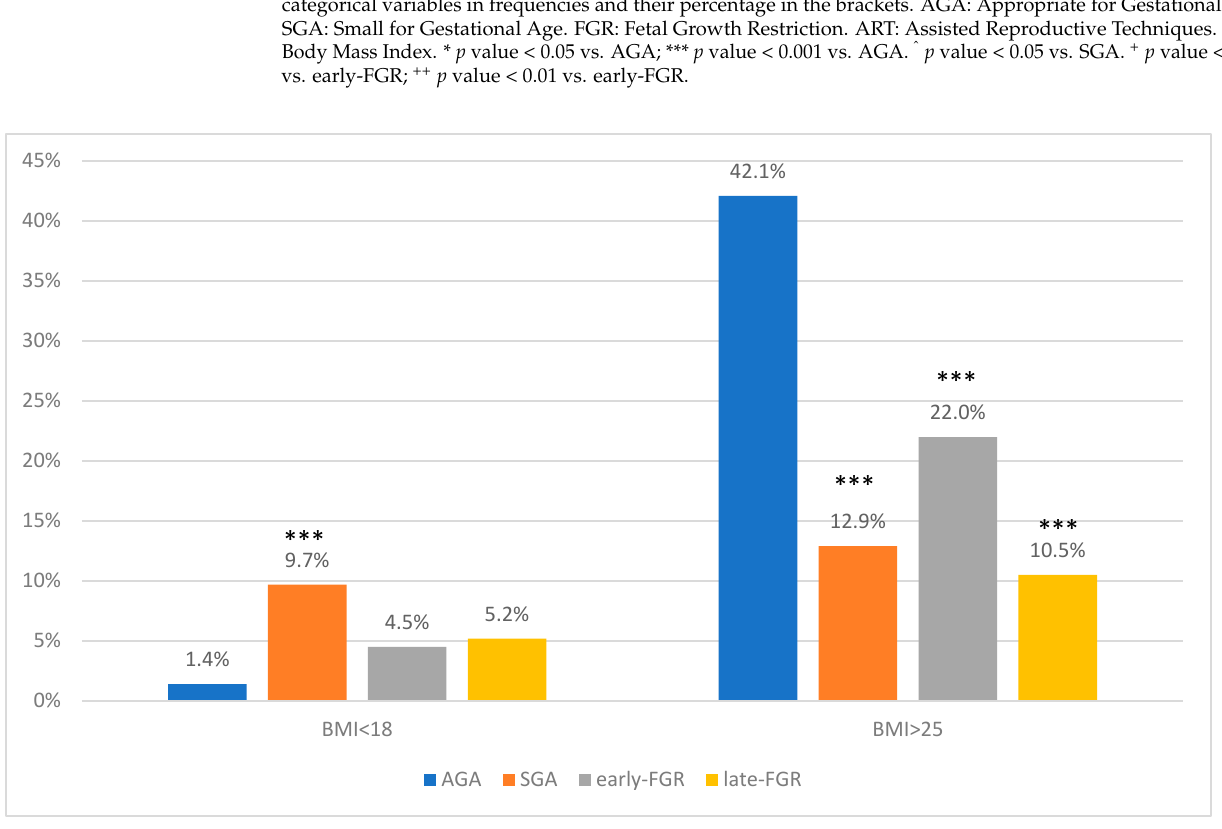
Figure 1. Maternal BMI < 18 or >25 in AGA, SGA, early-FGR, and late-FGR groups. *** p value < 0.001 vs. AGA. Table 2. Odds ratios (OR) of maternal BMI in SGA, early-FGR, and late-FGR fetuses.